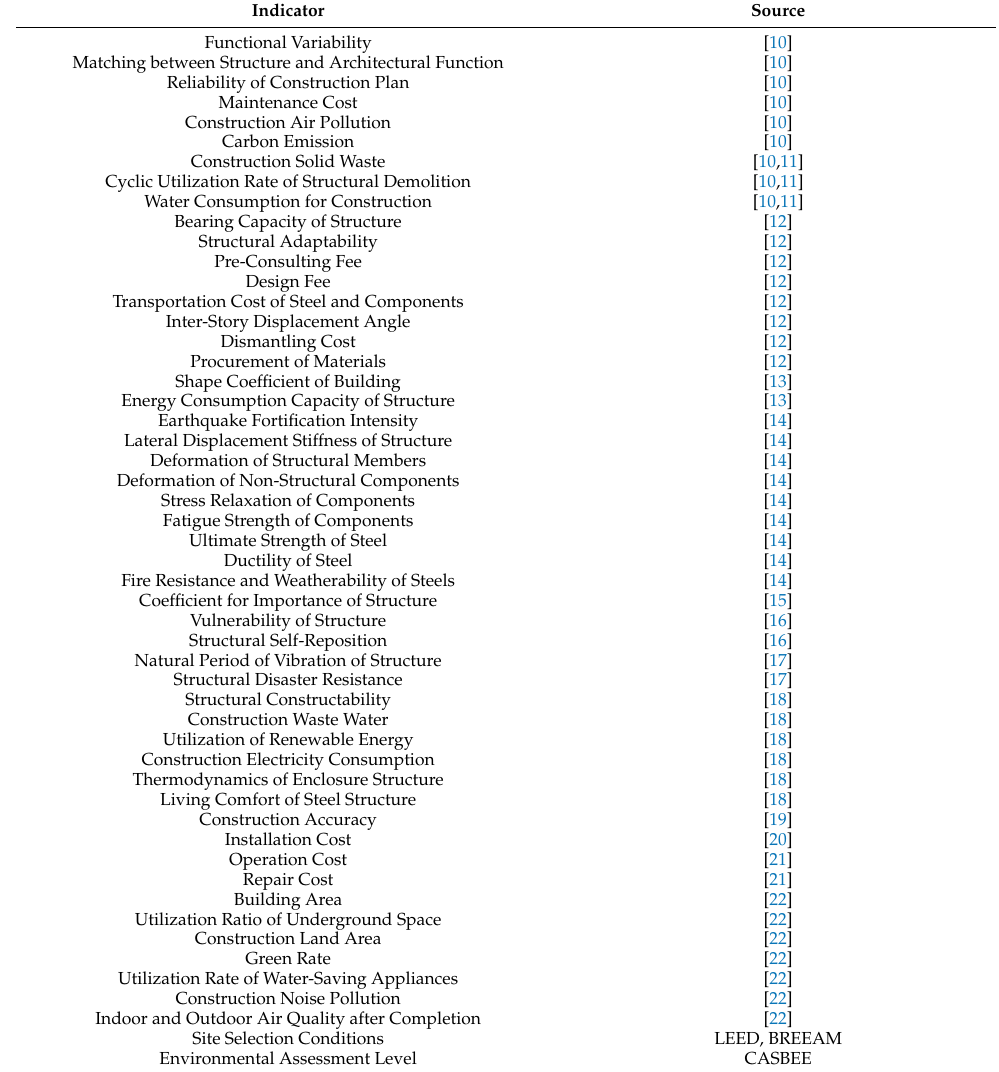
Table 1. Sustainability indicators for steel